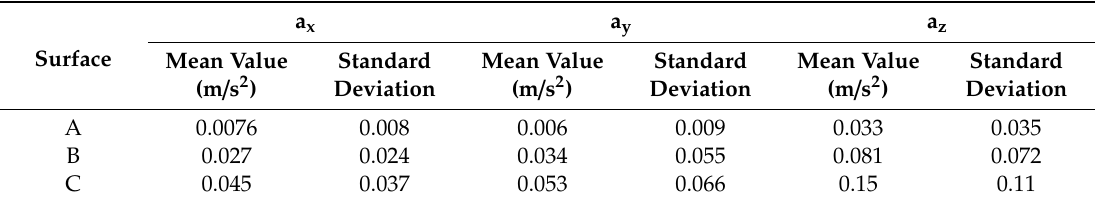
Table 4. Example of statistical values for amplitude spectra of the body acceleration for different road surfaces.